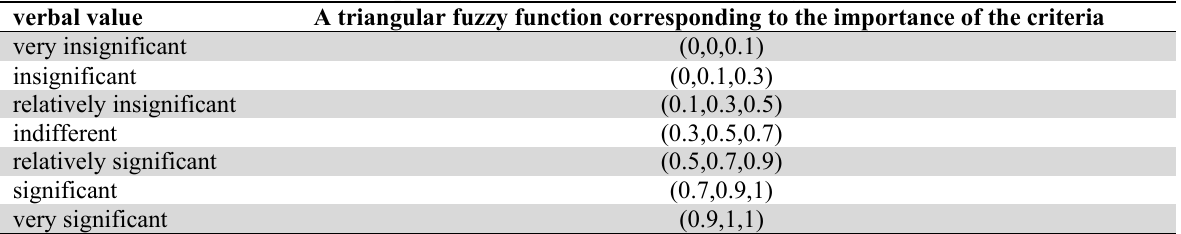
Verbal variables to evaluate the importance of criteria and model fuzzy criteria verbal